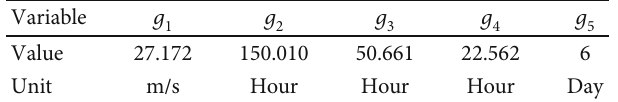
Table 5: Values of design metrics.